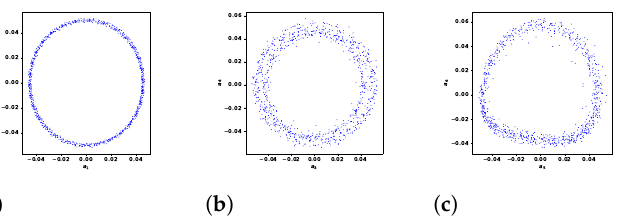
Figure 8. Coefficients phase diagram. ( a ) Modes 1 and 2; ( b ) modes 3 and 4; ( c ) modes 5 and 6.